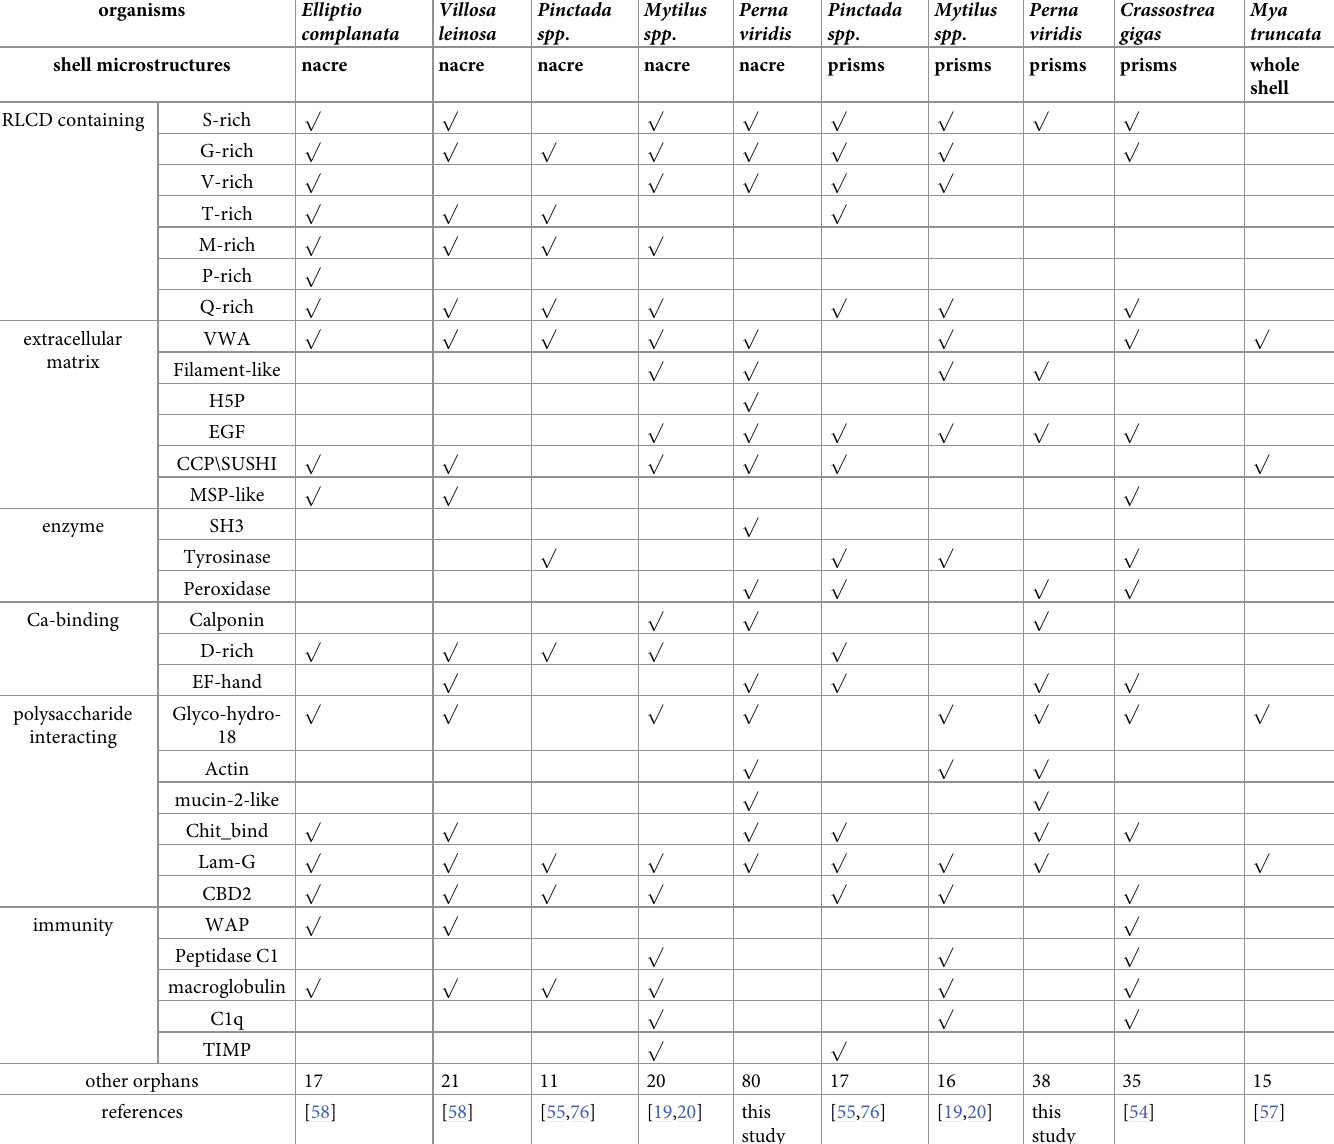
p ” indicates identification of this protein in this species.